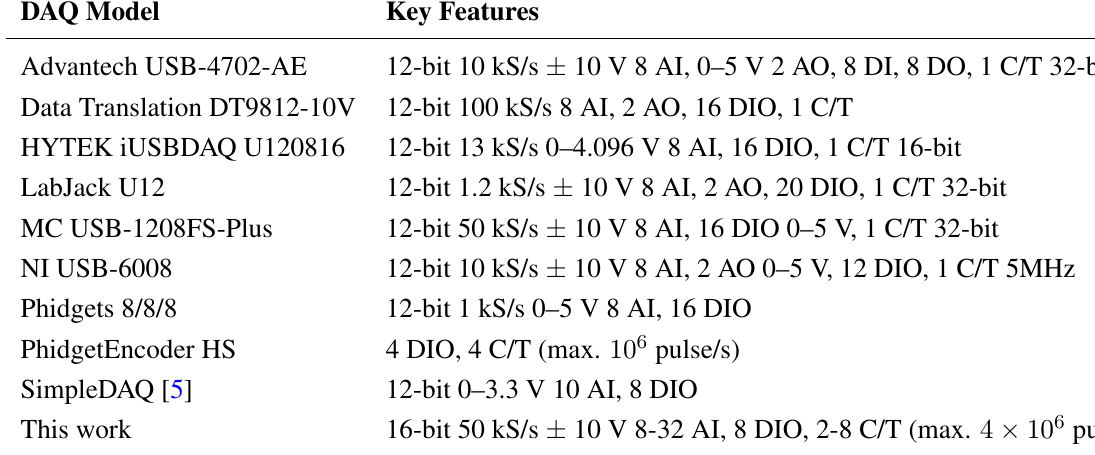
Table 1. Comparison of key features among other commercial and non-commercial USB DAQ devices, including their analog inputs (AI), digital inputs and outputs (DIO) and counter/timers ports